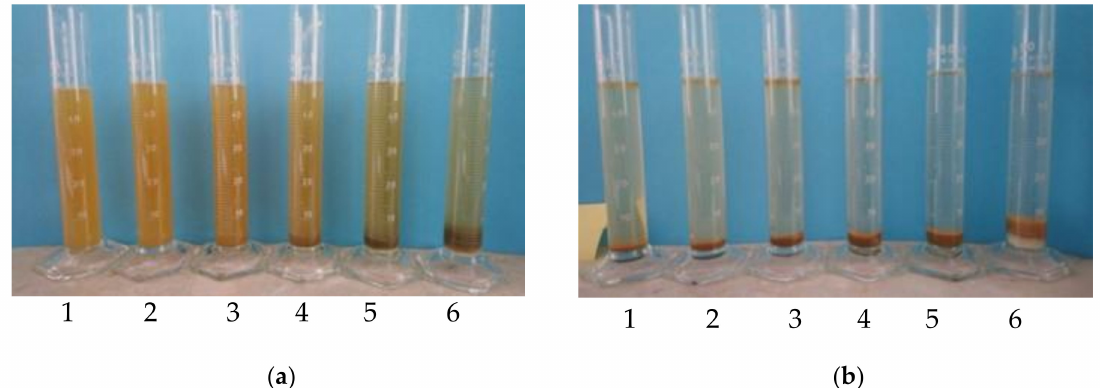
Figure 4. Influence of coagulant dose (1–50 µ L, 2–100 µ L, 3–200 µ L, 4–300 µ L, 5–600 µ L and 6–1200 µ L of SAX18 coagulant per 50 mL of flowback water) on the coagulation efficiency after ( a ) 30 min and ( b ) 1440 min.